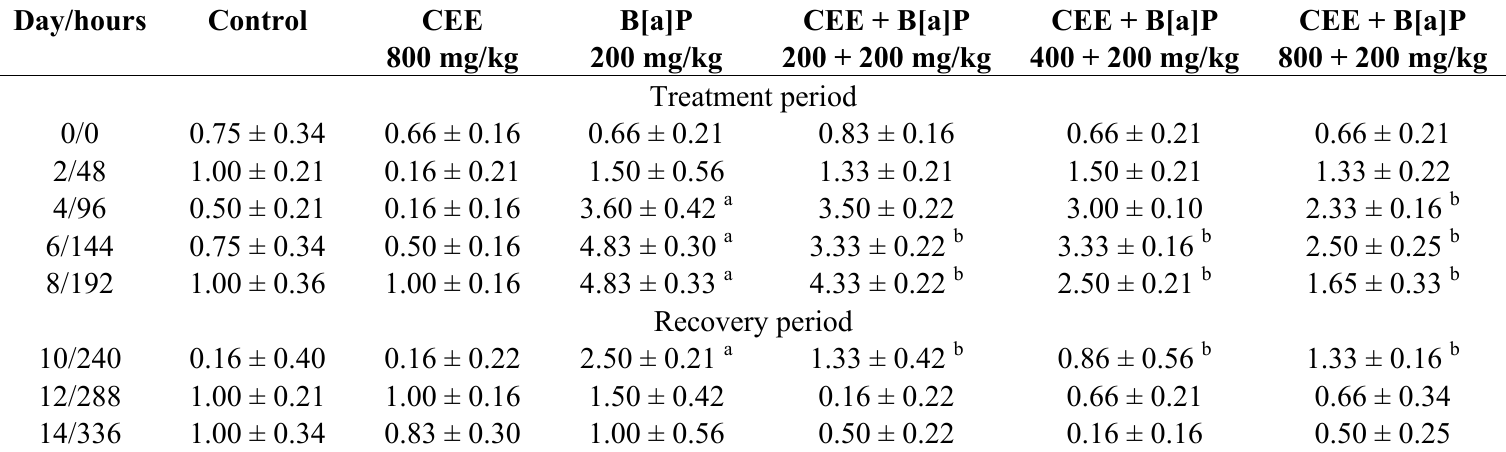
Table 3. Frequency of normochromatic micronucleated erythrocytes in mice treated with CEE and benzo[a]pyrene (X ±